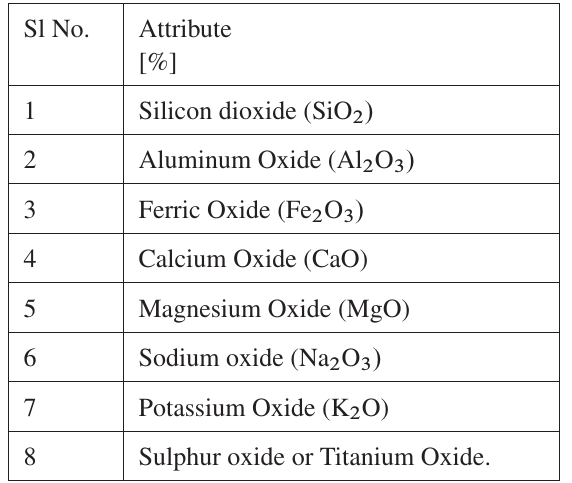
Table 1. The eight attributes.